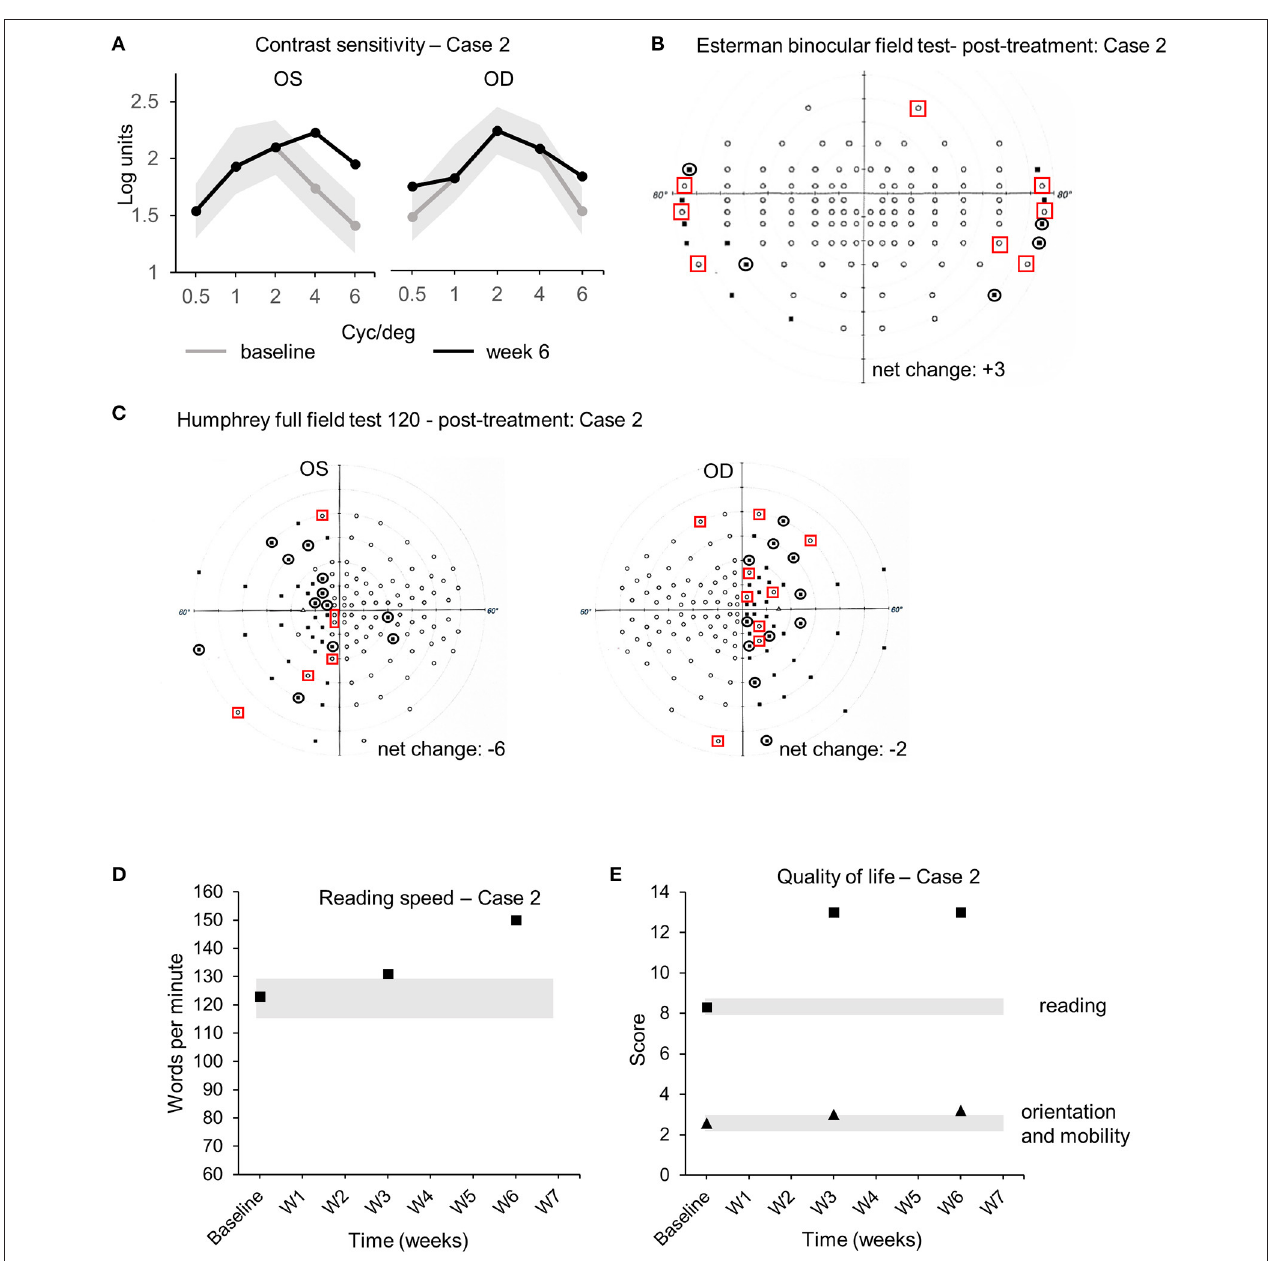
FIGURE 4 | Case 2—Visual outcome measures and quality of life. (A) Contrast sensitivity at baseline (gray line) and at the end of the treatment (week 6—black line) in the left (OS) and the right (OD) eye. (B) Esterman binocular field test post-treatment (week 6). Red squares indicate newly acquired points, and black circles indicate lost points, compared to baseline. (C) Monocular Humphrey full-field test (120 points) post-treatment (week 6) in the left (OS) and right (OD) eye. Red squares indicate newly acquired points, and black circles indicate lost points, compared to baseline. (D) Reading speeds at baseline, week 3, and post-treatment (week 6). (E) Quality of life scores at baseline, week 3, and post-treatment (week 6). Gray shaded areas in (A,D,E) indicate the values of the coefficient of repeatability ( ± COR). OD, oculus dexter ; OS, oculus sinister ; W, week.